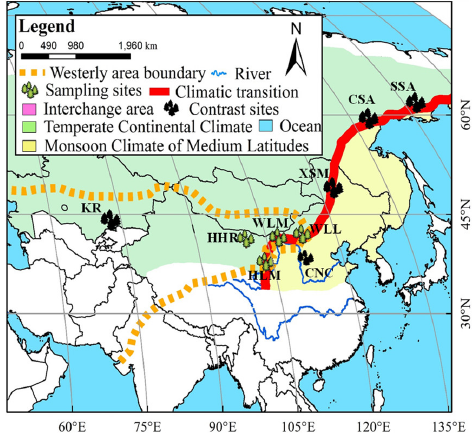
Figure 8. Distribution of the reconstruction locations in this study and other reconstruction locations in the Asian westerly jet area and the transition zone.